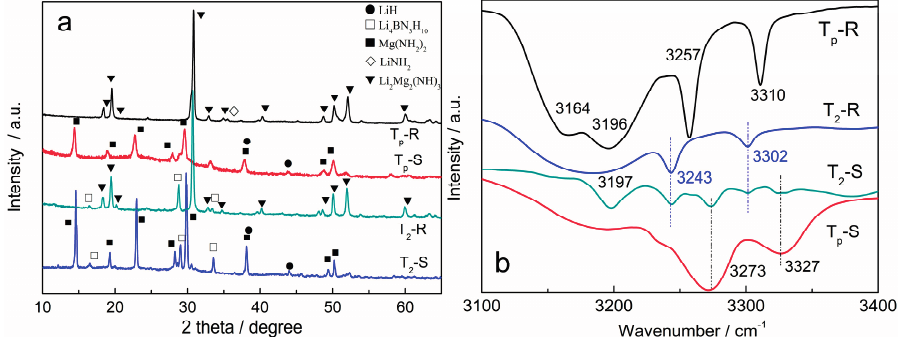
Figure 4. ( a ) XRD patterns and ( b ) FT-IR spectrum of 2Mg(NH 2 ) 2 –3LiH (T p ) and 2Mg(NH 2 ) 2 –3LiH–LiBH 4 (T 2 ) samples release (R) and soak (S) at 460